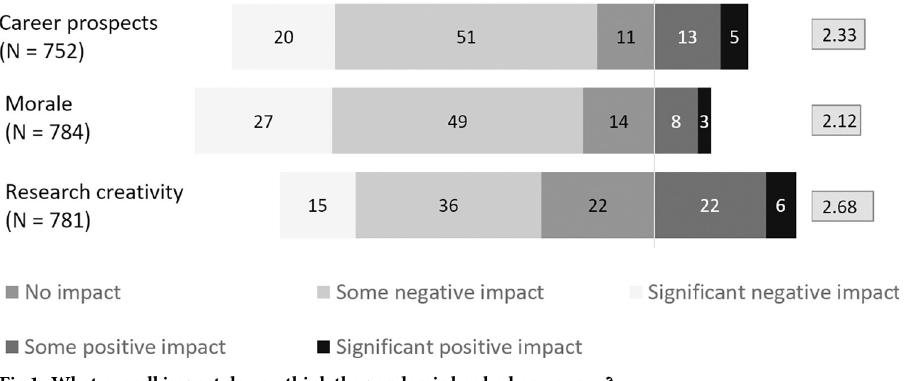
Fig 1. What overall impact do you think the pandemic has had on your ...